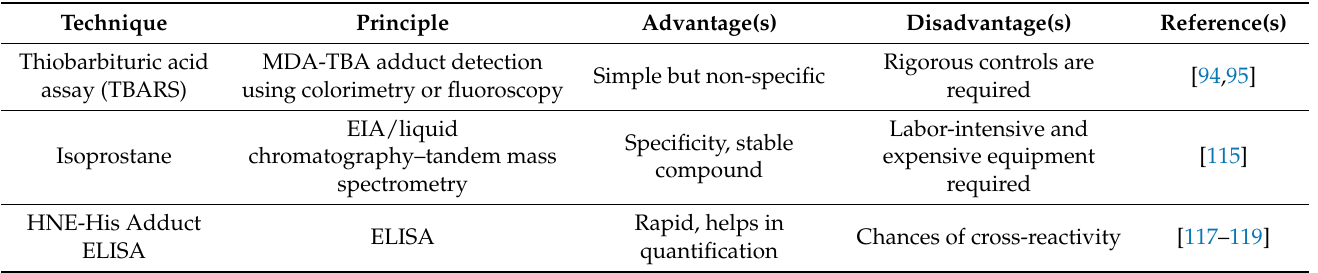
Table 3. Methods of measuring total antioxidant capacity